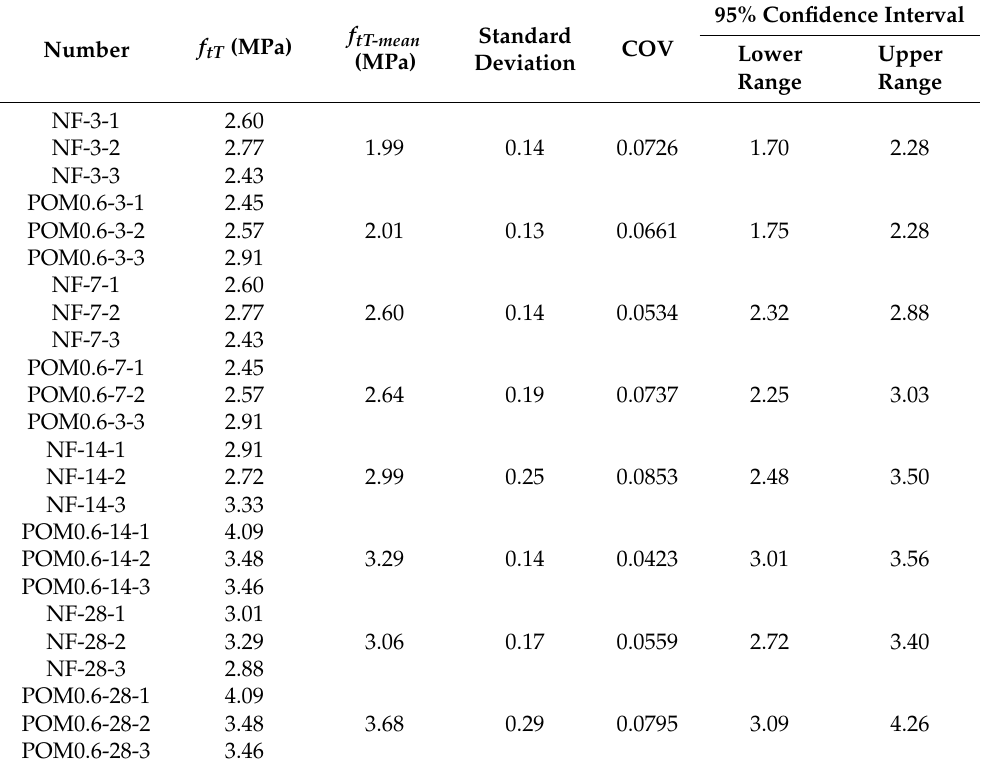
Table 7. Splitting tensile strength of NF and POM0.6 specimens with different